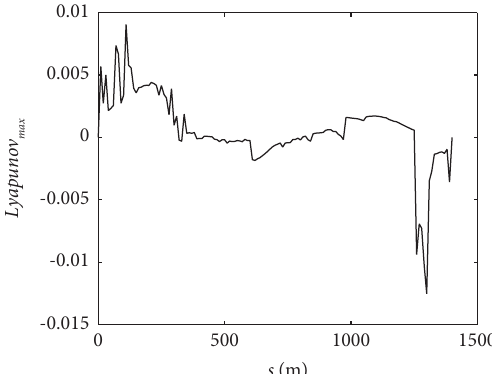
Figure 14: Maximum Lyapunov exponents of tangential displacement with cable coordinates.